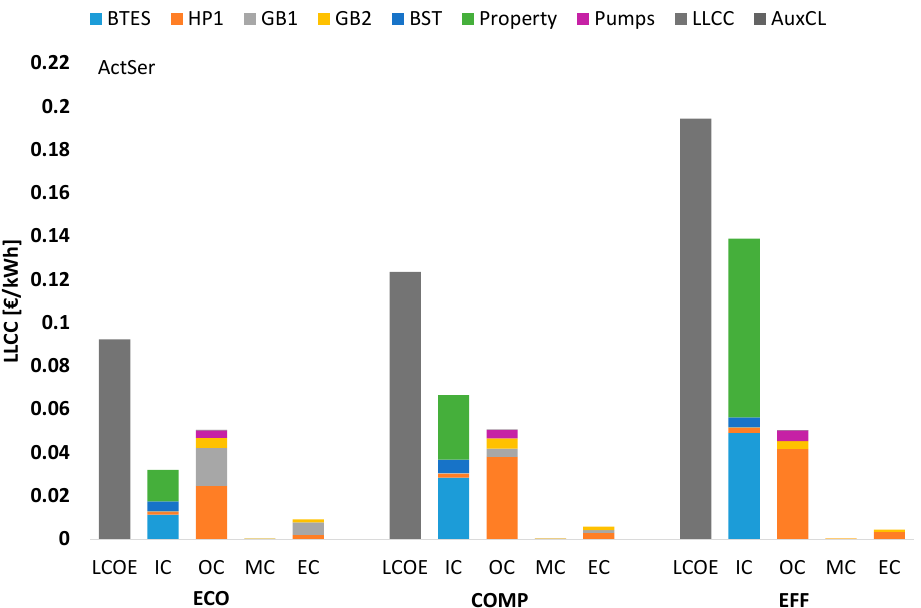
Figure 12. Component-wise exergy destruction and loss for the economical (ECO), the compromise (COMP) and the most efficient (EFF) designs in Table 7.